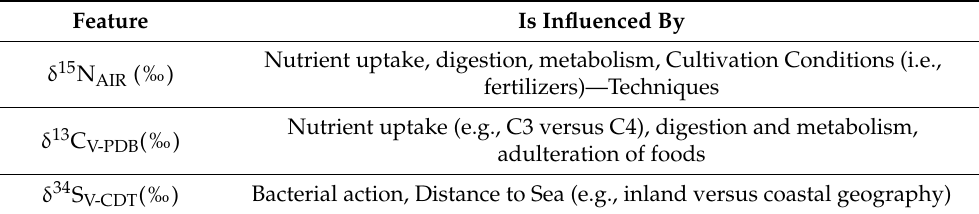
Table 1. List of primary